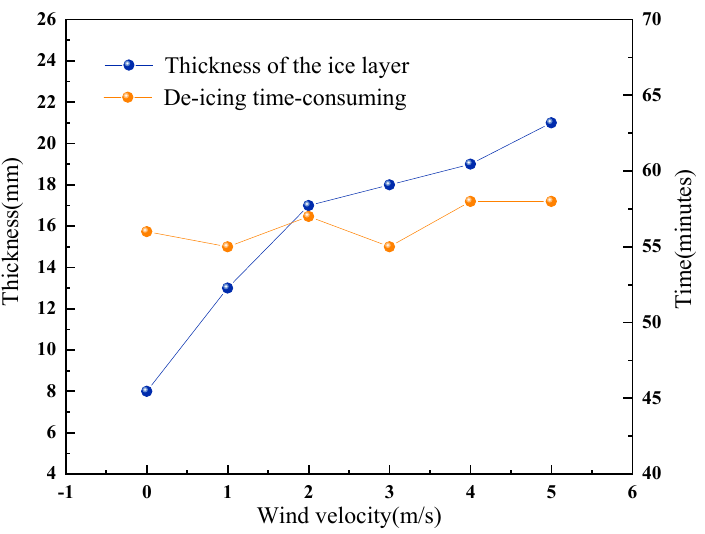
Figure 17. Variation of the de-icing time period with the wind velocity.